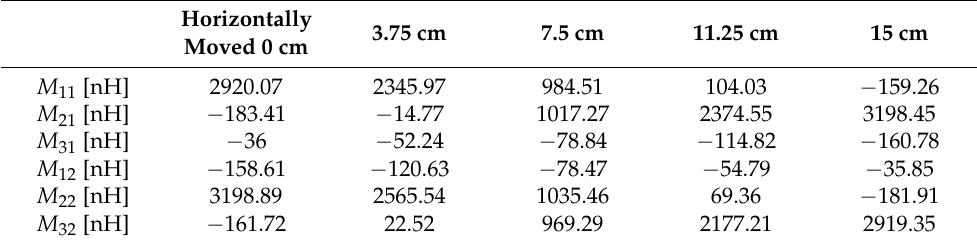
Table 4. Simulation Results of mutual inductance when there are both Rx coils on charging space.